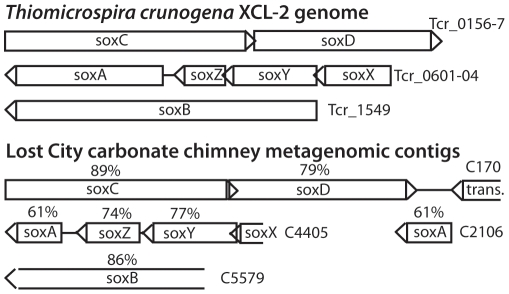
The Sox sulfur oxidation system of T. crunogena
[12], which encodes all enzymes necessary for complete oxidation of H2S to sulfate, is also present in metagenomic sequences from Lost City.In most organisms utilizing the Sox pathway, all genes are organized into a single cluster, but in both T. crunogena and the Lost City metagenome, soxB and soxCD are not contiguous with soxXYZA. Amino acid identities between putative orthologs are shown; note that the Lost City metagenome contains an additional copy of soxA not associated with other sox genes, and both copies are only 61% identical to T. crunogena and only 90% identical to each other. The Lost City soxX and soxB sequences are incomplete. The presence of a transposase downstream of Lost City soxCD is of potential interest considering strong evidence indicating lateral transfer of sulfur oxidation genes among bacteria [23]. Accession numbers for contigs C170, C4405, C2106, and C5579 are ACQI01000170, ACQI01004405, ACQI01002106, and ACQI01005579, respectively.